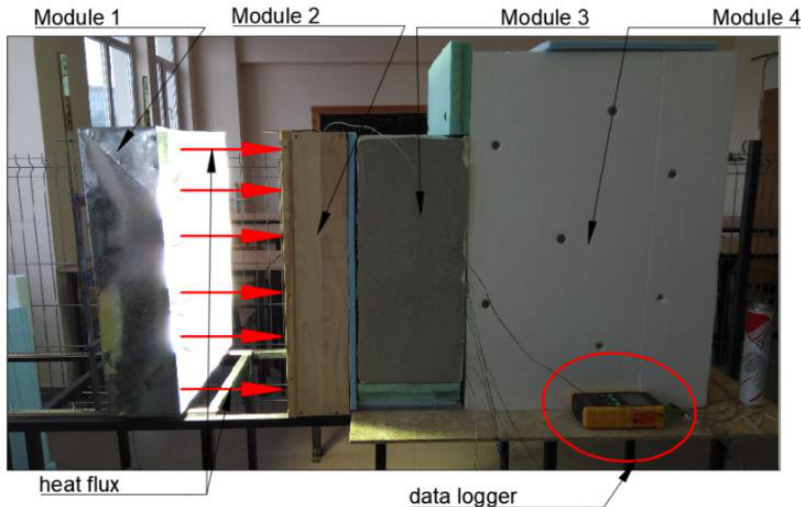
Figure 1. The experimental setup of the global system. The third module consists of an insulated concrete wall equipped with heat pipes. The concrete block has a length of 0.6 m, a width of 0.4 m, and a thickness of 0.2 m. Four concrete samples were cast with standard aggregates and waste aggregates in the mixture: CW01—corresponds to the concrete control sample; CW02—corresponds to concrete with 10% fly ash replacement for cement and 20% chopped PET replacement for the sand mass; CW03—corresponds to concrete with 10% fly ash replacement for cement and 20% sawdust replacement for the sand mass; CW04—corresponds to concrete with 10% fly ash replacement for cement, 10% granular polystyrene with dimensions between 1 and 4 mm replacement for the sand mass and 20% granular polystyrene with dimensions between 4 and 8 mm replacement for the aggregate sort. The 4th module consists of the insulated room built from wood plates. This module is insulated using a polystyrene layer of 0.1 m at the exterior to prevent heat loss. The concrete blocks were built according to previous research [30], which analyzed the density, compressive strength, and thermal conductivity of several concrete samples mixed with various percentages of fly ash, chopped PET, sawdust, and granular